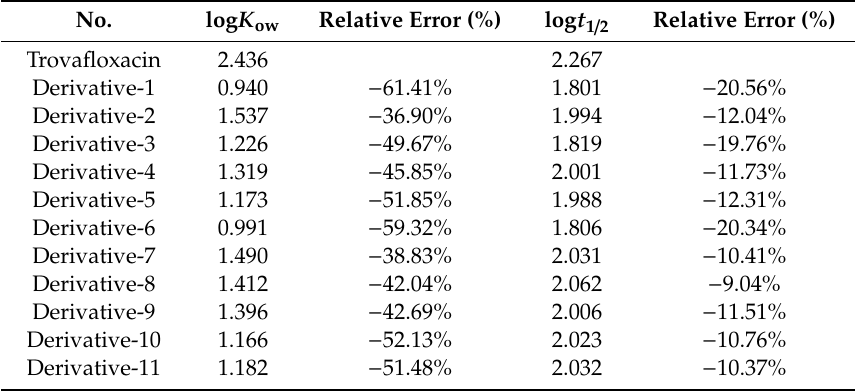
Table 3. Predicted log K ow and log t 1 / 2 values of quinolone derivatives using QSAR models.